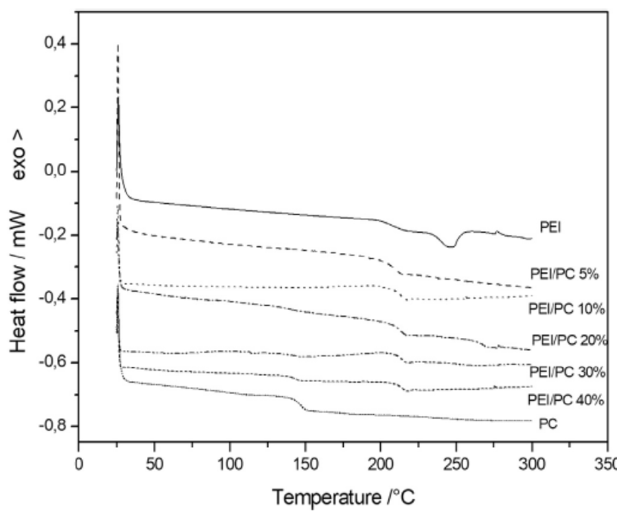
Figure 4. DSC curves for PEI, PC, and the various blends. Reprinted from [21] with permission from Elsevier.